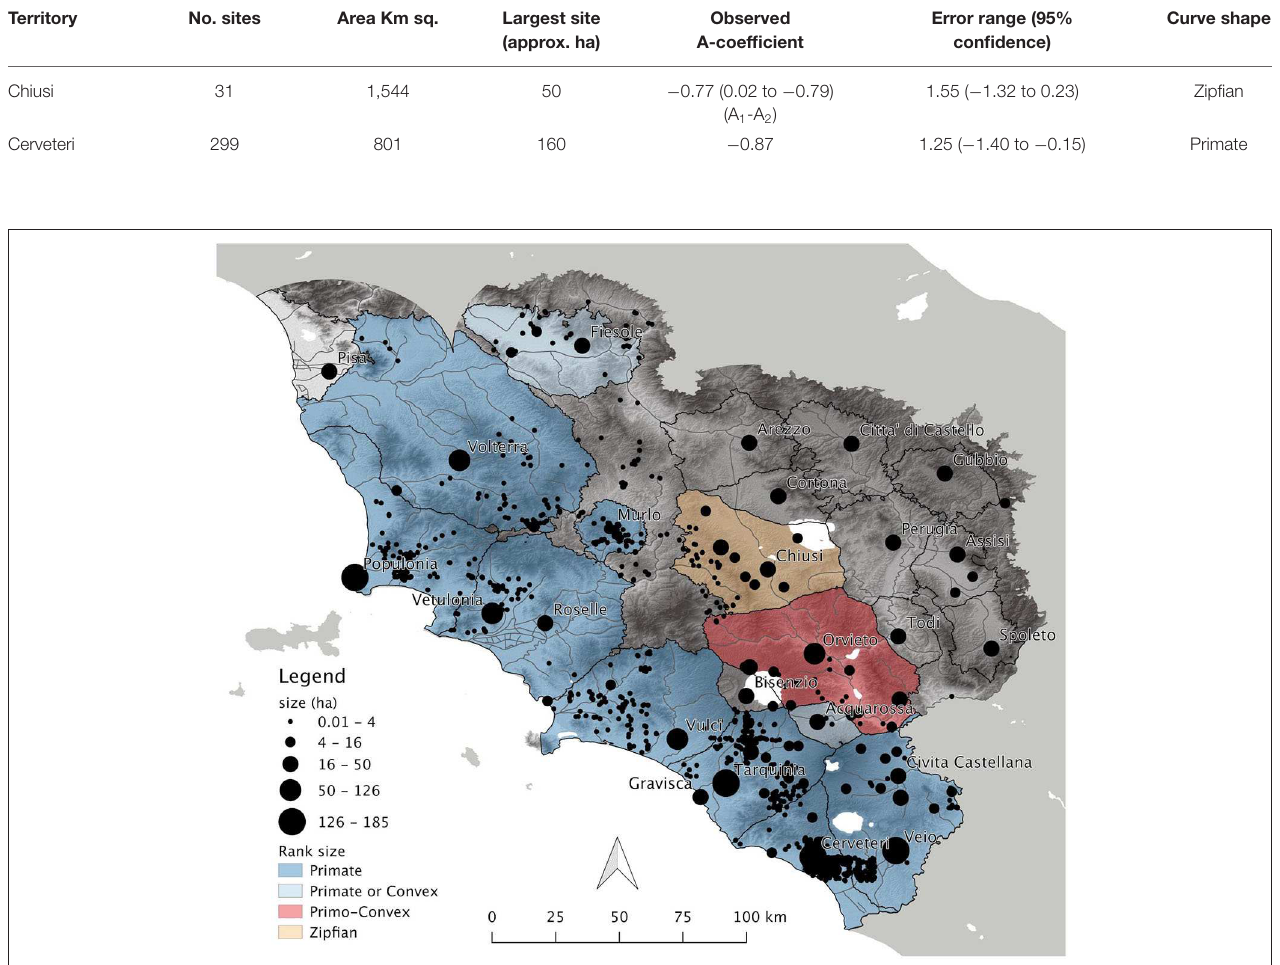
FIGURE 11 | Presentation of new data for Chiusi (f) and Cerveteri (k) in spatial